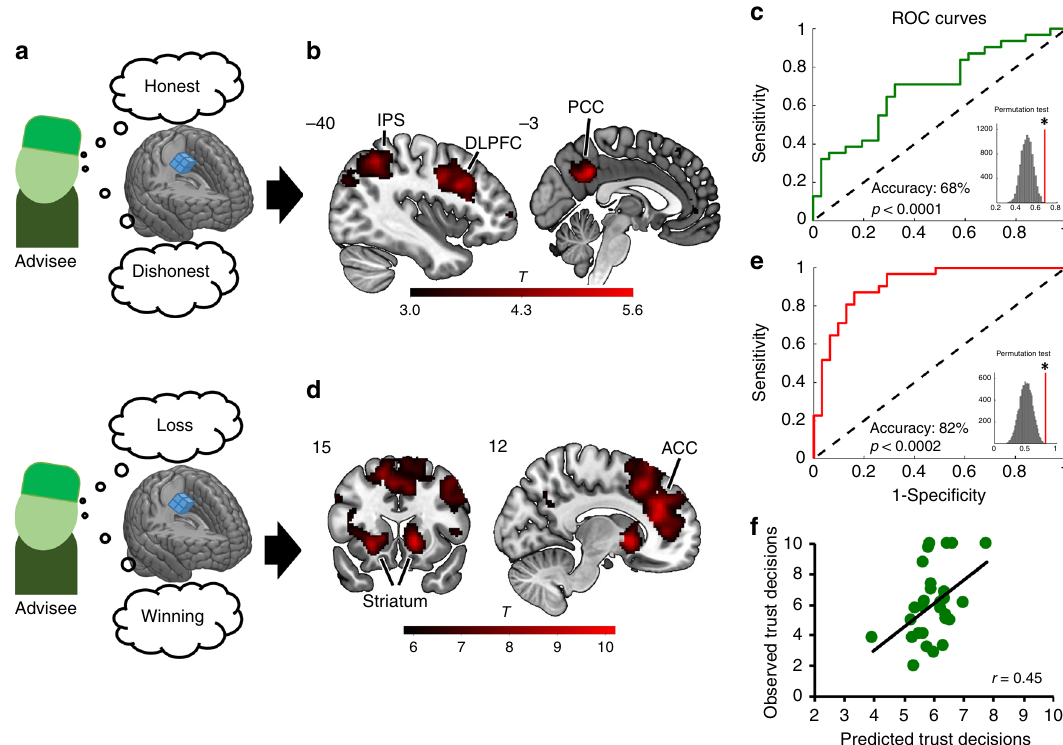
Fig. 3 Decoding honesty and predicting trust. In two MVPAs applied to the feedback phase of the TAG ( a ), a support vector machine (SVM) was trained to decode honest and dishonest advice (GLM1) to determine the trustworthiness decoding network (upper), and to decode winnings and losses (GLM2) to determine the value decoding network (lower). The trustworthiness decoding network ( b ) included brain regions such as the PCC, DLPFC, and IPS, and could successfully distinguish neural signatures of honesty and dishonesty in out-of-sample individuals ( c ). The value decoding network ( d ) included the striatum and ACC and could successfully distinguish neural signatures of winnings and losses in out-of-sample individuals ( e ). Finally, a multivariate prediction analysis with support vector regression (SVR) showed that the neural patterns of the trustworthiness decoding network successfully predicted individual economic trust decisions in the TG, thereby showing across-context generalizability ( f ). Both out-of-sample classi fi cation and prediction analyses were based on a leave-one-subject-out cross-validation procedure and their signi fi cance tested using a permutation test with 10,000 permutations. Each dot represents one participant. See also Supplementary Fig. 2 and Supplementary Table 1. MVPA, multivariate voxel pattern analysis; TAG, take advice game; PCC, posterior cingulate cortex; IPS, intraparietal sulcus; DLPFC, dorsolateral prefrontal cortex; ACC, anterior cingulate cortex; TG, trust game. Heatmap represents t